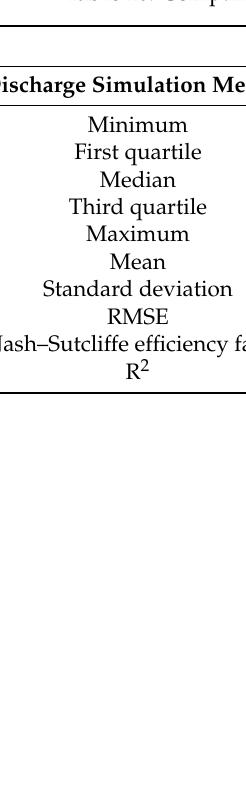
Table 11. Comparison of the distributions and statistics of the runoff blending result for the Socheon SHP plant. (Unit: m 3 /s) Discharge simulation